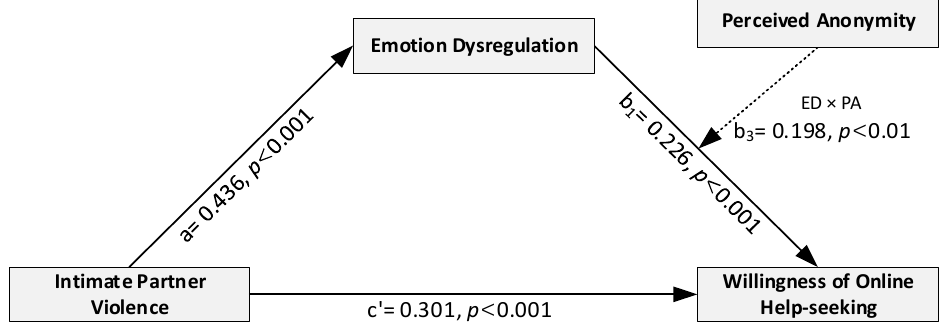
Figure 2. The coefficient estimates and statistical significance of the moderated-mediation model. Table 3. Ordinary least squares regression results for moderated effect.